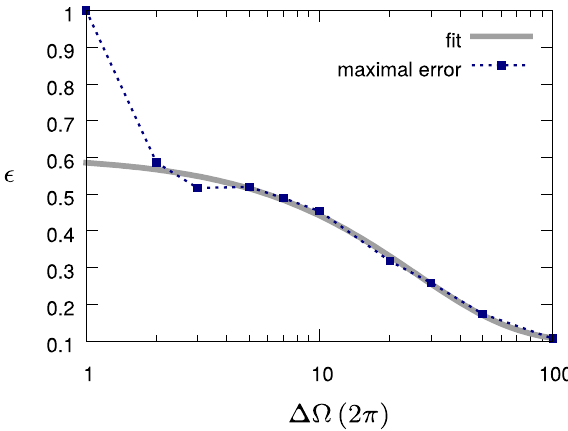
Figure 2. Decay channel (“Decay channel” section): Control error scaling with respect to the maximum bandwidth (cid:31)(cid:30) . The control error ε is reduced when a higher bandwidth allows faster transitions between the two states. The figure shows the maximal control error over 100 random instances of input and target states (blue squares). If the bandwidth is too low, then we do not have any control over the quantum system and the maximal error is given by the form of the error function (in our case ε points (grey solid line, ’fit’) with the error model of Eq. (61), as described in the text, with a 1 0.098 and c 1 =